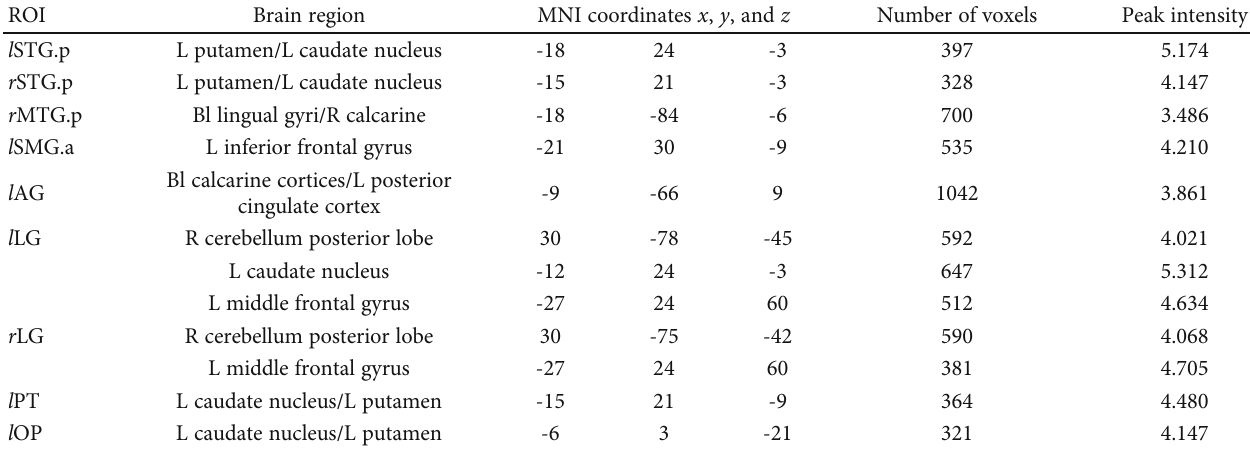
STG: superior temporal gyrus; MTG: middle temporal gyrus; SMG: supramarginal gyrus; AG: angular gyrus; LG: lingual gyrus; PT: planum temporale; OP: occipital pole; L or l : left; R or r : right; Bl: bilateral; a: anterior division; p: posterior